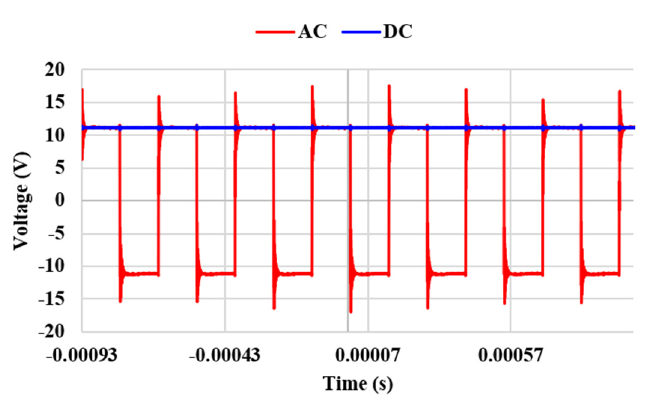
Figure 11. Output V AC and input V DC of full-bridge GaN inverter without snubber circuits; Excel spreadsheet is extracted from Analog Discovery.